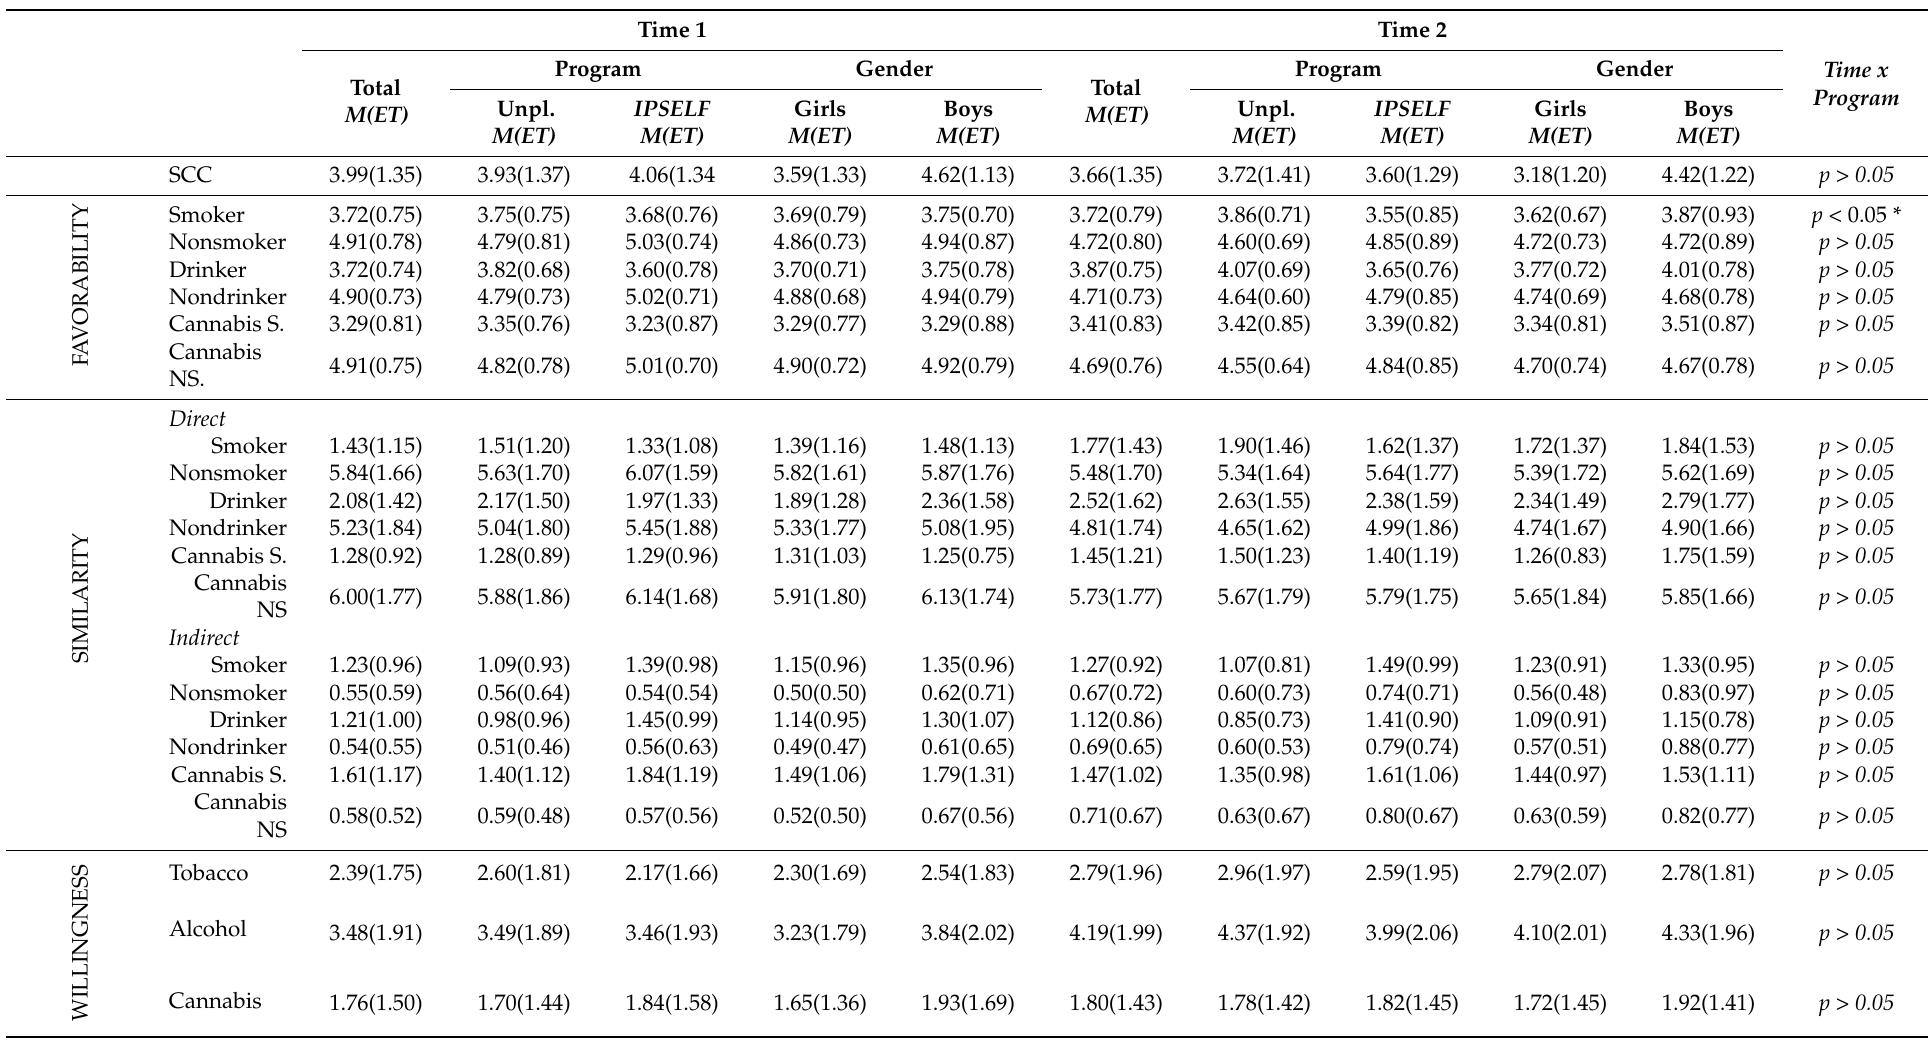
Table 1. Means at different scales by program and